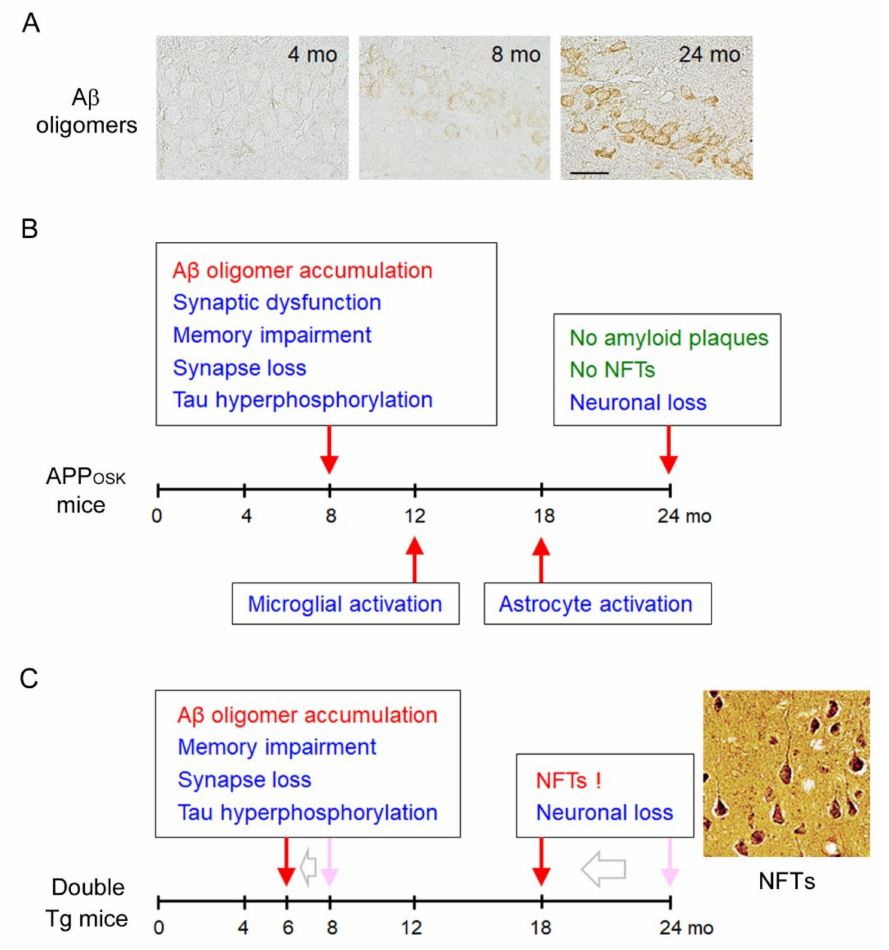
Figure3. PhenotypesofAPP OSK mice. ( A )IntraneuronalaccumulationofA β oligomersinAPP OSK mice. The mice started to accumulate intracellular A β oligomers at 8 months. Images of the hippocampus are shown. Scale bar = 30 µ m. ( B ) A β oligomers alone can induce most AD pathologies except for neurofibrillary tangles (NFT) formation. ( C ) The double Tg mice expressing both the Osaka mutation and wild-type human tau displayed NFTs at 18 months. Intracellular A β oligomers and tau might interact to accelerate each other’s